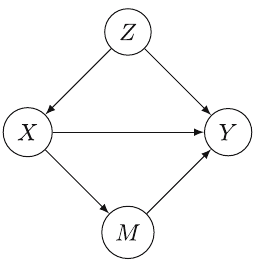
Figure 2: Possible causal graph explaining the relationship between variables in Example